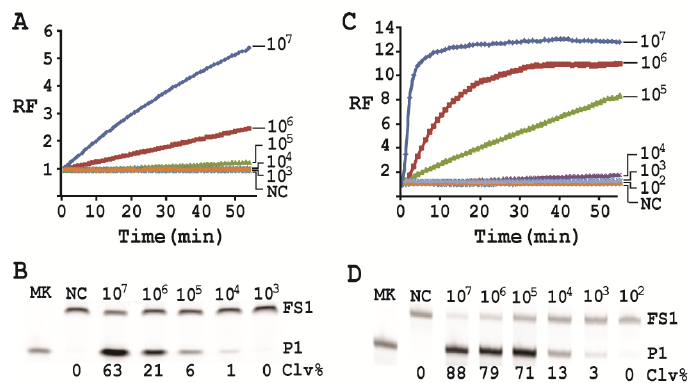
Figure 6. Sensitivity test. ( A ) Real-time fluorescence monitoring and ( B ) dPAGE analysis of EC1T/FS1 in the presence of CIMs prepared from 10 3 –10 7 E. coli cells. ( C ) and ( D ) Similar experiments using RNA-cleaving fluorogenic DNAzyme (RFD-EC1) with CIMs prepared from 10 2 –10 7 E. coli cells. The data in (A) and (C) are the average of two independent